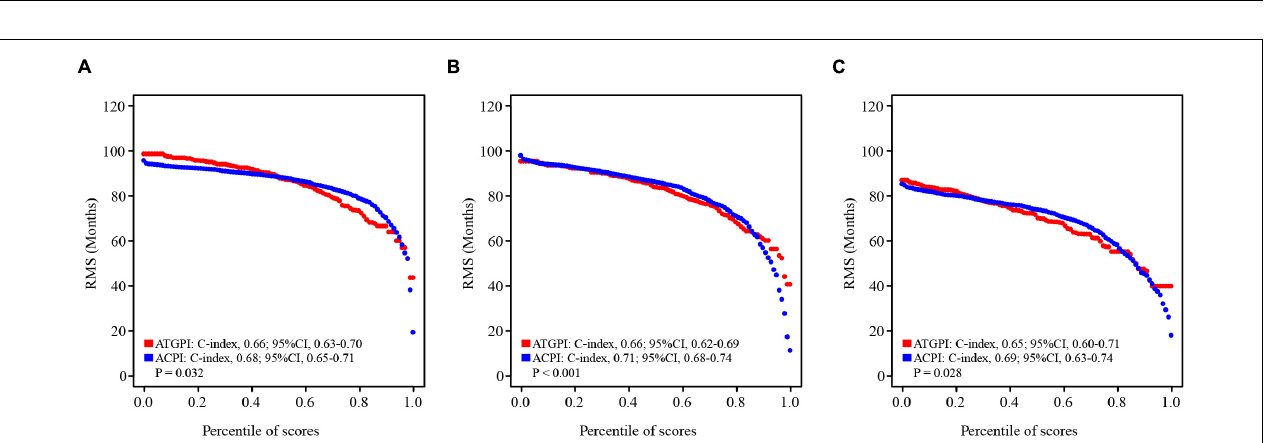
FIGURE 6 | The restricted mean survival (RMS) curves for autophagy-related gene pair index (ATGPI) and autophagy clinical prognostic index (ACPI) in the training, testing, and The Cancer Genome Atlas (TCGA) validation cohorts. (A–C) The RMS curves for the ATGPI and ACPI in the training cohort, the testing cohort, and the TCGA validation cohort. Each point demonstrates the RMS time of corresponding ATGPI and ACPI value. The slope of RMS curves was larger, the estimation for overall survival was better. Concordance index (C-index) was used to represent the difference between the ATGPI and ACPI.